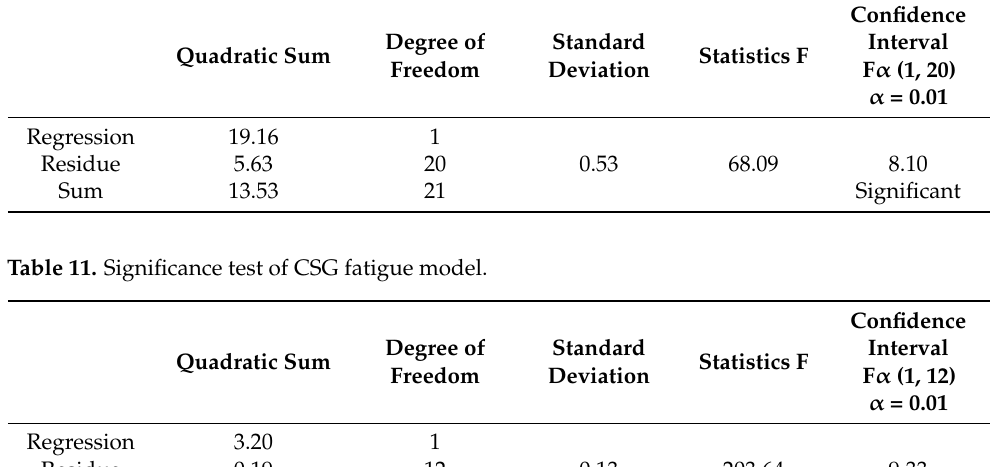
Figure 13. Fitting curves of CSG fatigue test. Table 10. Significance test of CSG fatigue model.